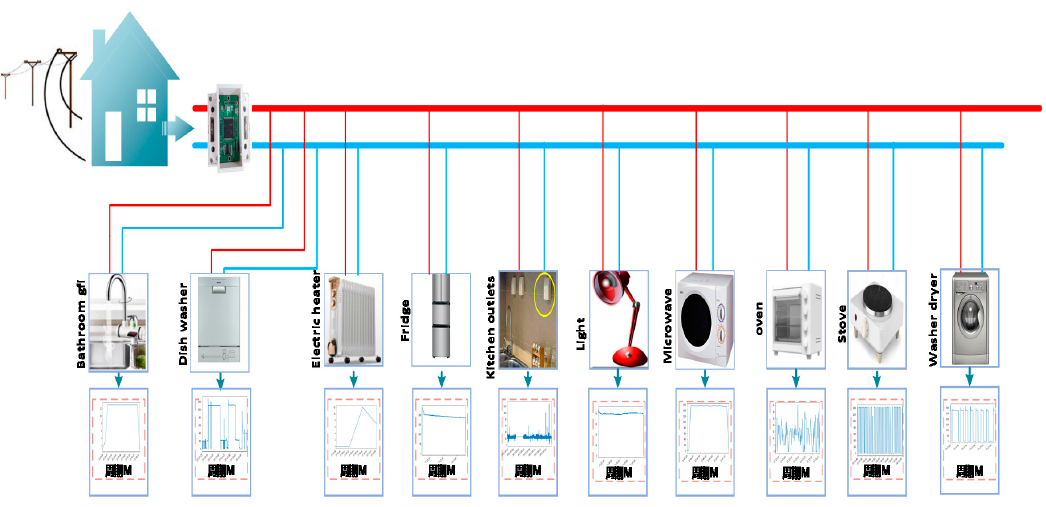
Figure 3. House1 electrical distribution map.